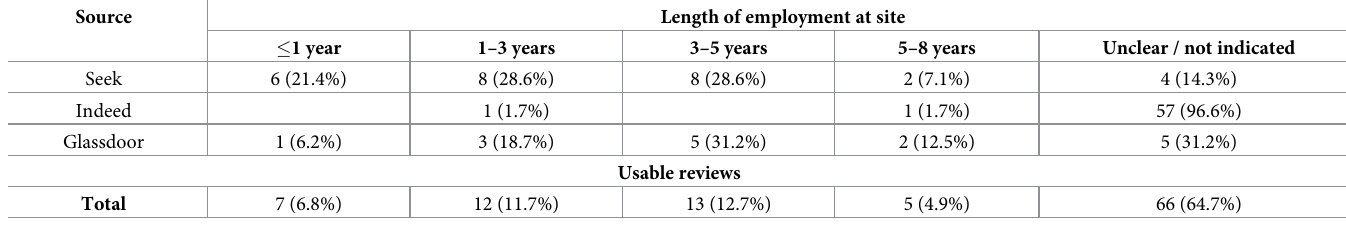
Table 4. Length of employment at hospital site indicated by reviewers across